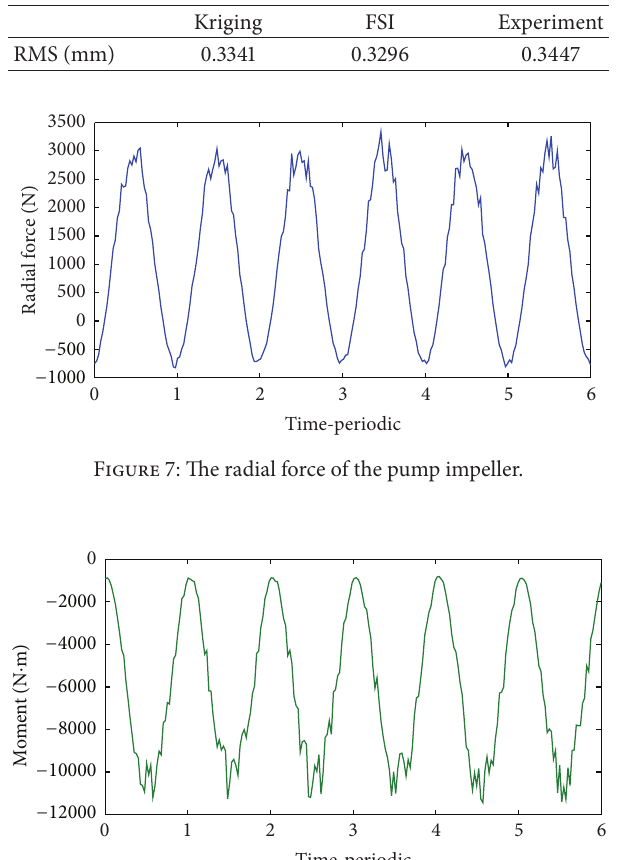
Table 7: Results of Kriging, FSI simulation, and experiment.